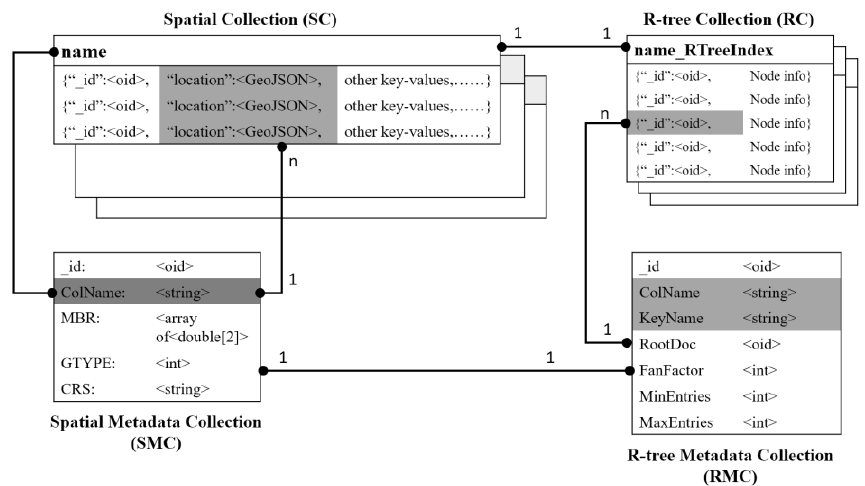
Figure 2. The R-tree related storage schema.